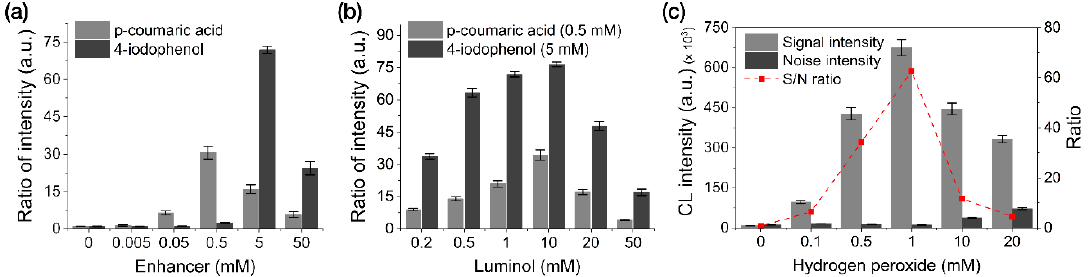
Figure 3. Optimization of the reagent concentrations used for the CL reactions in our LFA framework.